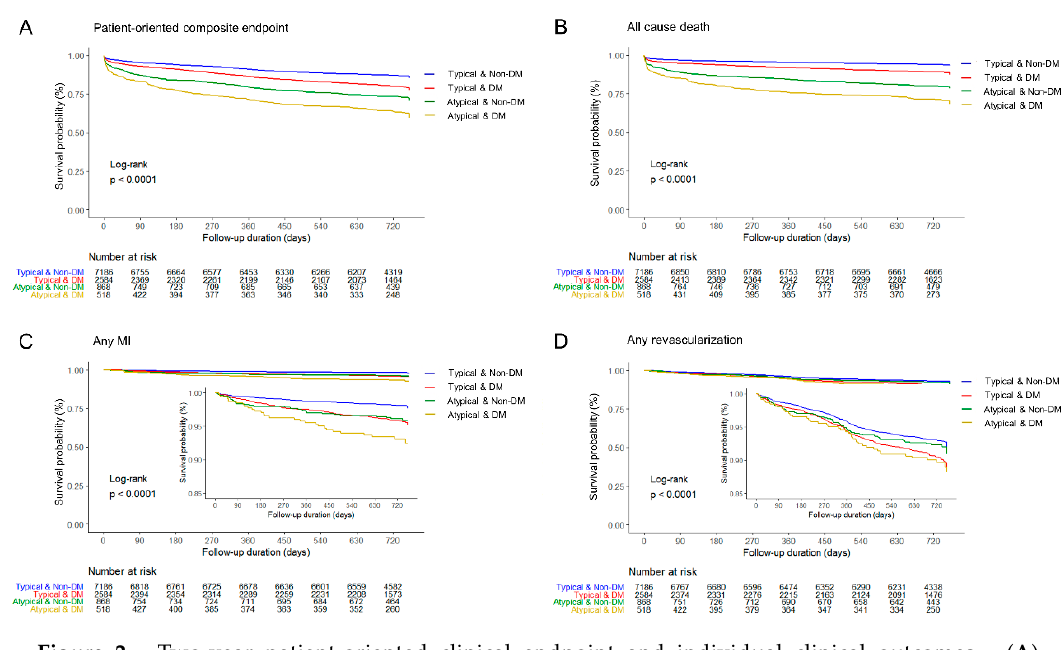
Figure 2. Two-year patient-oriented clinical endpoint and individual clinical outcomes. ( A ) Patient-oriented composite endpoint, ( B ) All-cause death, ( C ) Any myocardial infarction, and ( D ) Any revascularization. DM, diabetes mellitus; MI, myocardial infarction. J. Clin. Med. 2020 , 9 , x FOR PEER REVIEW